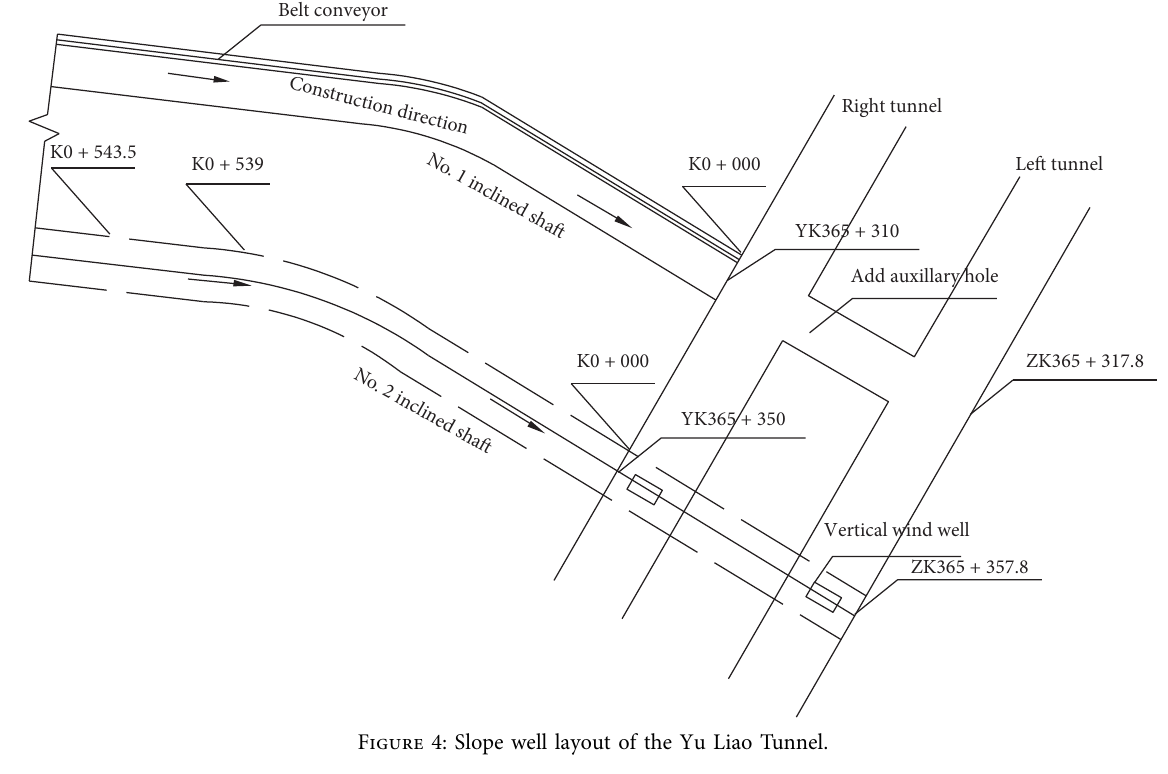
Figure 4: Slope well layout of the Yu Liao Tunnel.